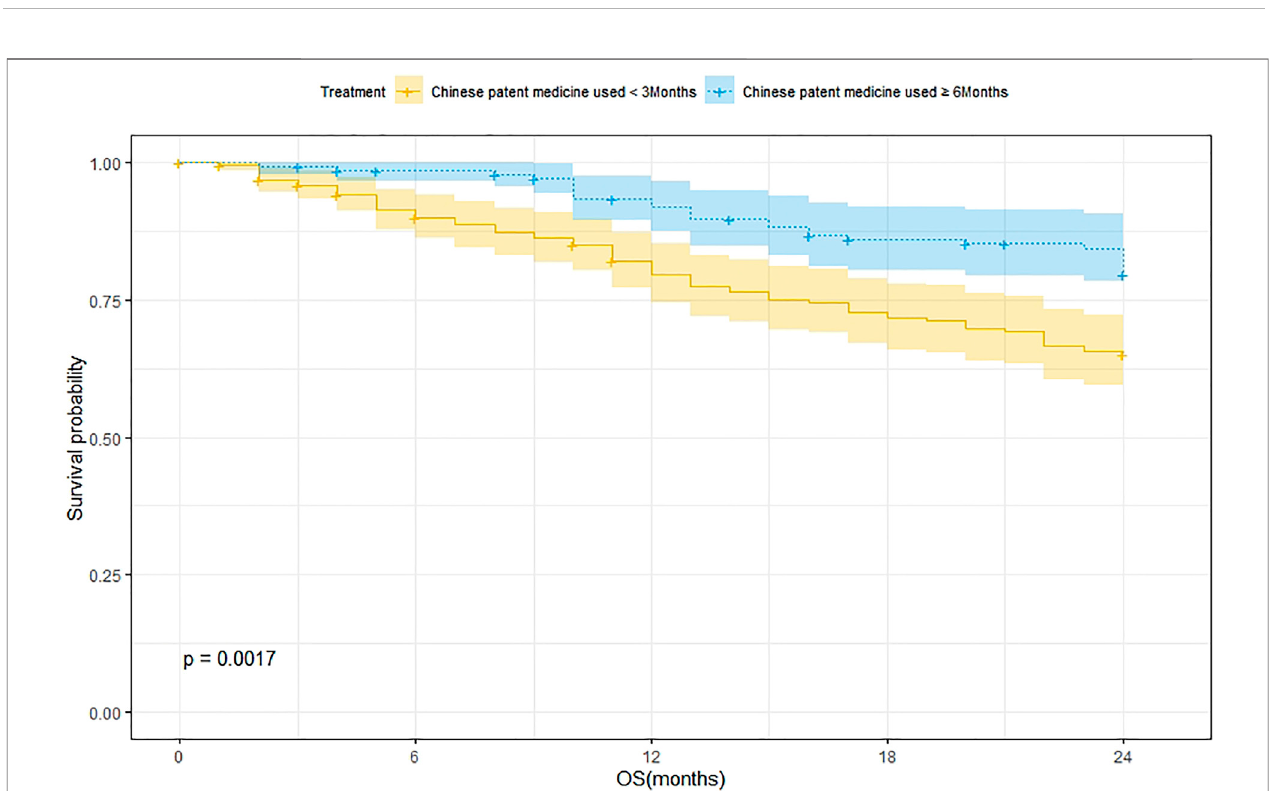
FIGURE 3 | Survival analysis of patients treated with CPM for < 3 months and patients treated with CPM for ≥ 6 months.